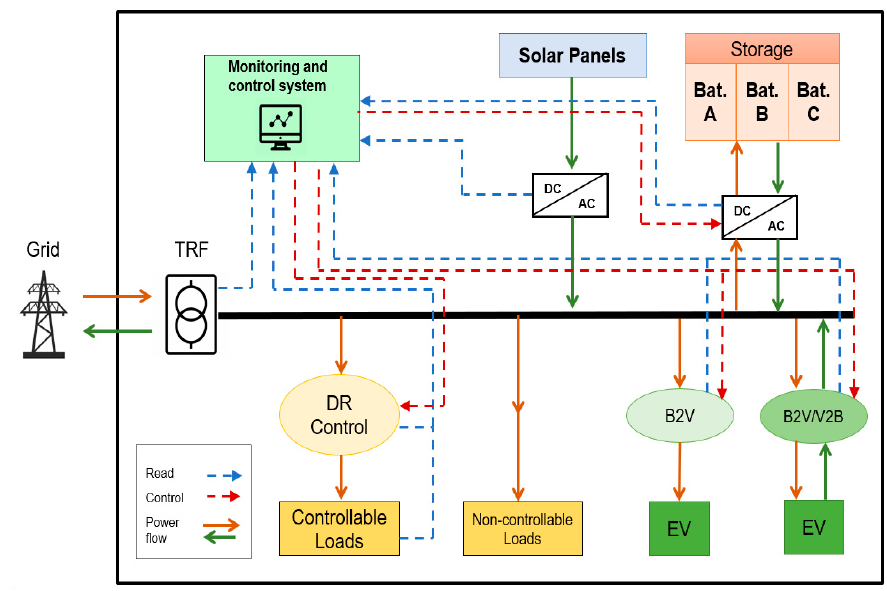
Figure 1. DEEC microgrid schematic.